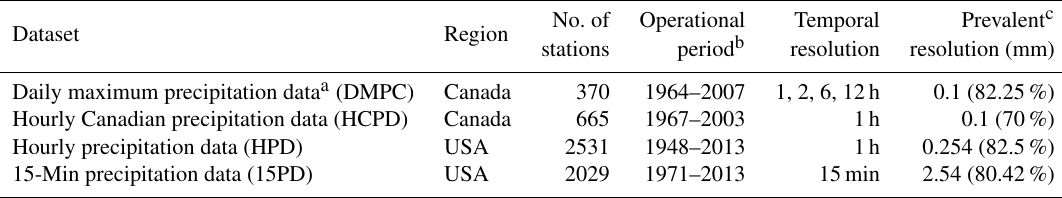
Table 1. List of available datasets and their main characteristics. Dataset